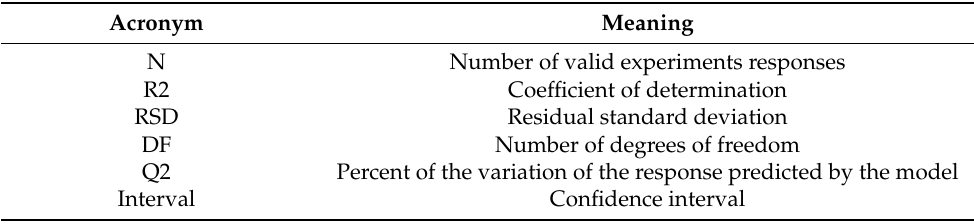
Table 8. Acronyms of the statistical analysis.